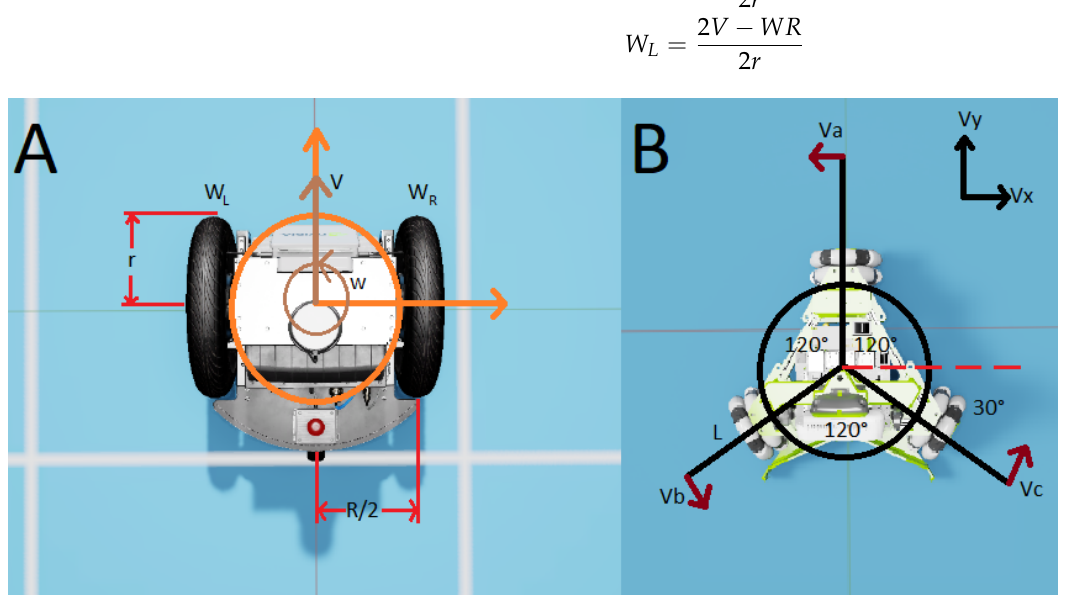
Figure 6. Geometric representation of the different robot bases included in the library, being ( A ) dif- ferential, and ( B )